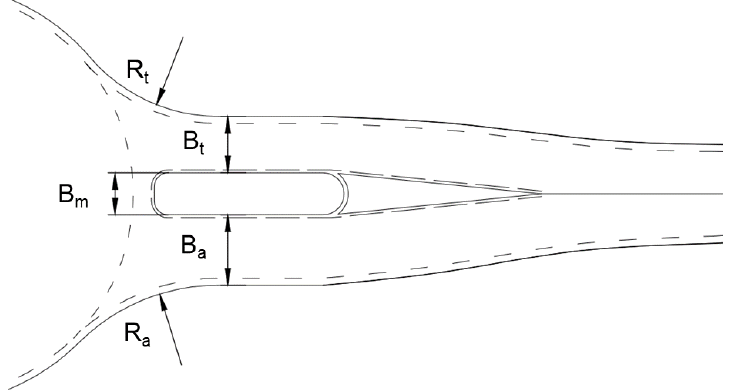
Figure 23. Design elements of entry and exit at suburban single-lane roundabouts according to [8]. According to [9], the approaches should be perpendicular to the roundabout, which is achieved by radially laying the approach axis to the outer radius of the intersection. The center of the roundabout must be as close as possible to the intersection of the approach axis. At suburban roundabouts, the recommended entry lane width in the vicinity of the splitter island (“B Z ”) ranges from 3.50 to 4.00 m, whereas the recommended exit lane width (“B A ”) is in the range of 3.75 to 4.50 m (Figure 23). The rounding of the right edge of